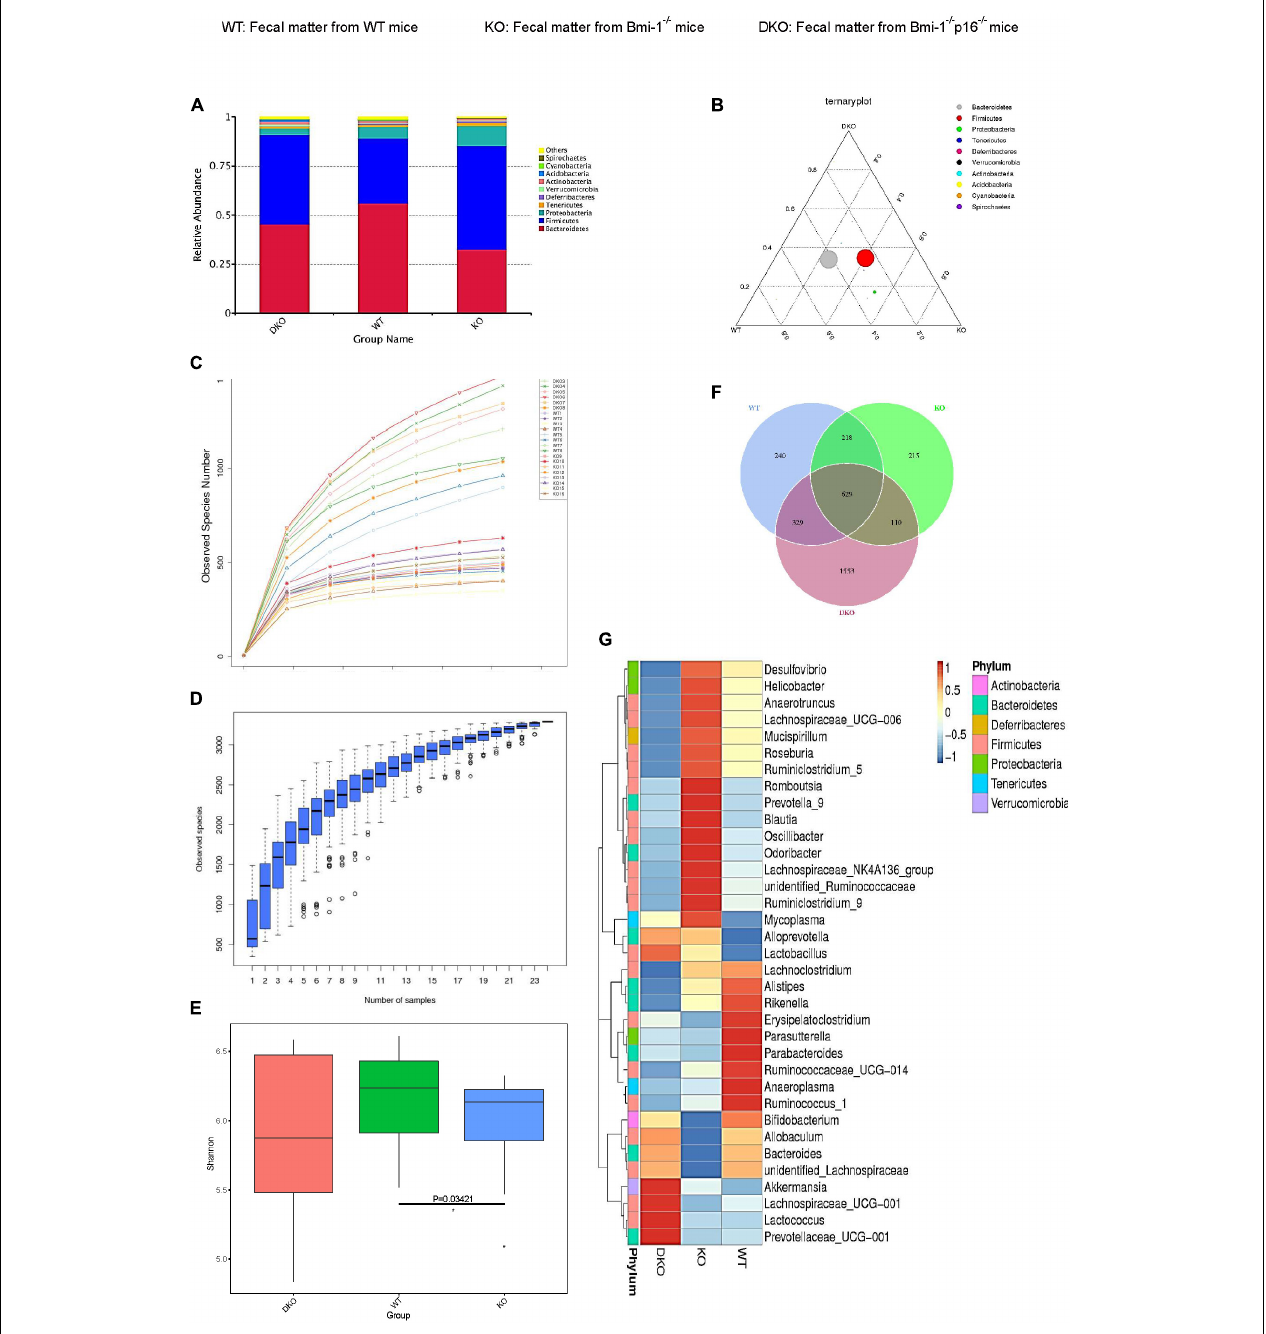
FIGURE 7 | P16 deletion improved intestinal microbial dysbiosis in Bmi-1 − / − mice. High-throughput sequencing of V4 region amplicon of 16S rRNA from intestinal microbiota was conducted using the fecal of 7-week-old WT, Bmi-1 − / − (KO), and Bmi-1 − / − p16 − / − (DKO) mice. (A) Principal components at the phylum level in the intestinal microbiota of WT, Bmi-1 − / − , and Bmi-1 − / − p16 − / − mice. Relative contribution of the top 10 phylum of each sample was shown; “others” represents the sum of abundance except the top 10 phylum, n = 8. (B) Proportion of intestinal microbiota in 7-week-old WT, KO, and DKO mice at the phylum level. Circle represents a taxonomy at the level of phylum; the size of the circle represents the abundance of the microbiota at the phylum level. (C) Abundance display curve of intestinal microbiota in WT, KO, and DKO mice. Abscissa represents sequencing depth; ordinate represents the number of species found. (D) Box plot showing abundance dilution. The end of the curve is close to gentle, indicating that the sample size of sequencing meets the requirements of diversity. (E) The observed species number and α -diversity index of intestinal bacteria were examined. Significant differences are indicated: Wilcoxon rank sum test, n = 8 per group, * p < 0.05, compared with the WT group. (F) Venn diagrams demonstrate the number of species shared among WT, KO, and DKO groups. (G) Heat map showing distribution of intestinal microbiota at genus level from 7-week-old WT, Bmi-1 − / − , and Bmi-1 − / − p16 − / − mice; the phylum of each genus is listed in the note, n = 8. The heat map is colored based on row Z scores. The mice with the highest and lowest bacterial levels are in red and blue, respectively.